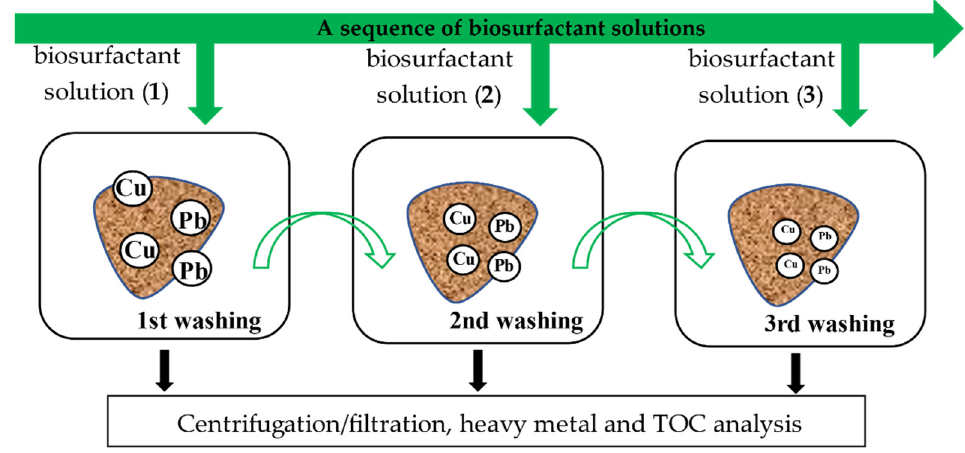
Figure 1. Sequential soil washing procedure with biosurfactant solutions.